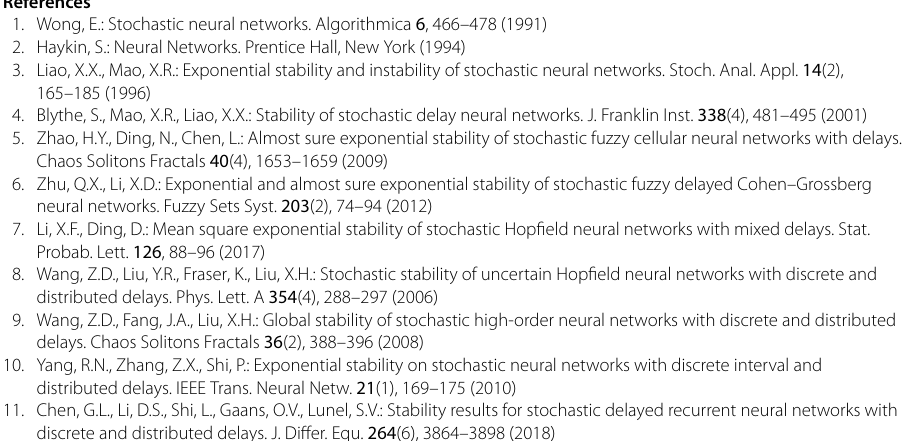
Acknowledgements Not